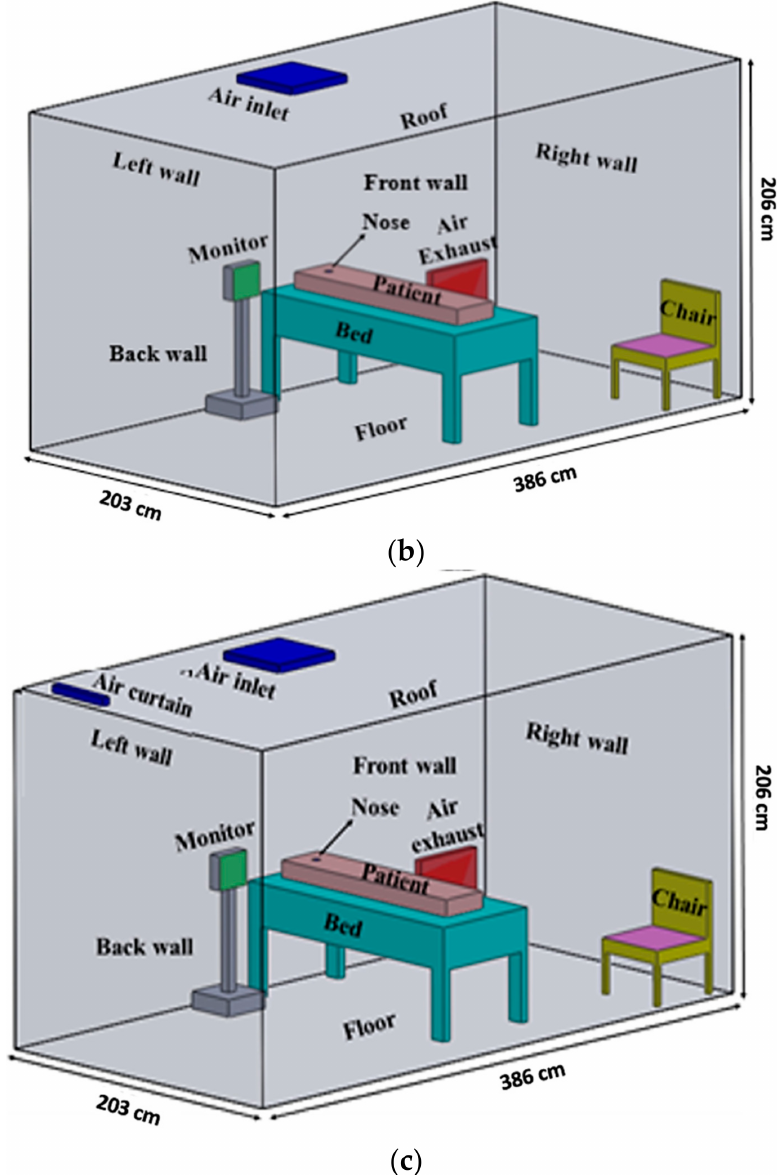
Figure 5. Hospital model room configuration ( a ) with the air inlet in the ceiling on the left, exhaust on the right; ( b ) with the air inlet in the ceiling above the bed, exhaust at the bottom left on the wall; and ( c ) with the air inlet in the ceiling above the bed, exhaust at the bottom left on the wall, air curtain entry/door. The schematics are showing the dimensions of the room and the positions of the objects in the